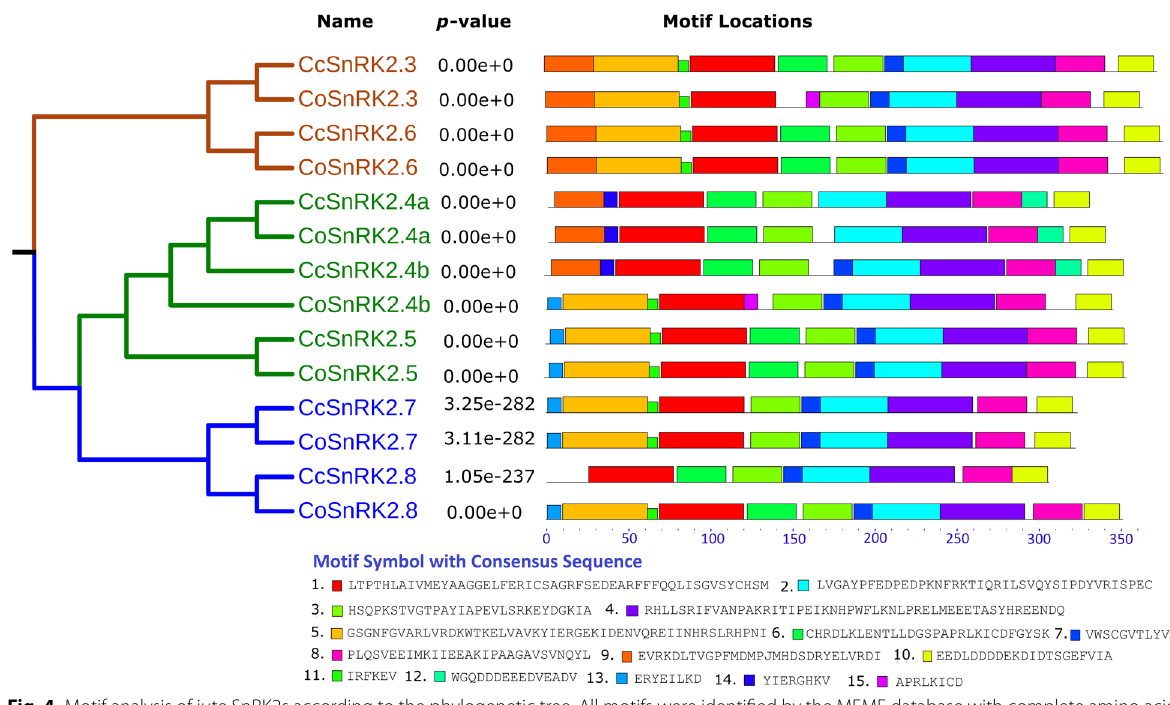
Fig. 4 Motif analysis of jute SnRK2s according to the phylogenetic tree. All motifs were identified by the MEME database with complete amino acid sequences of CoSnRK2s and CcSnRK2s . The length of the motif for each SnRK2s protein is displayed